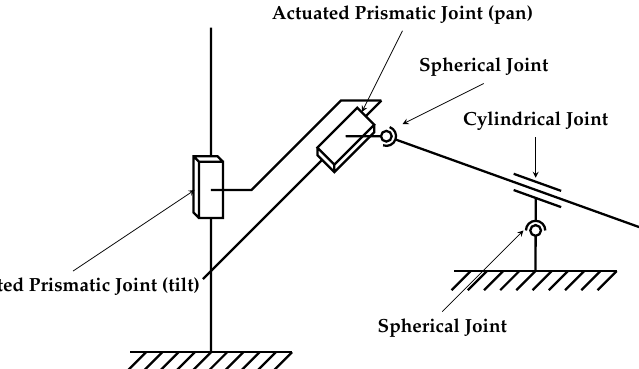
Figure 5. Kinematic visualization of the proposed high-precision pointing mechanism. The two actuated prismatic joints comprise the XY-Table, while the two spherical and the cylindrical joints make up the lever